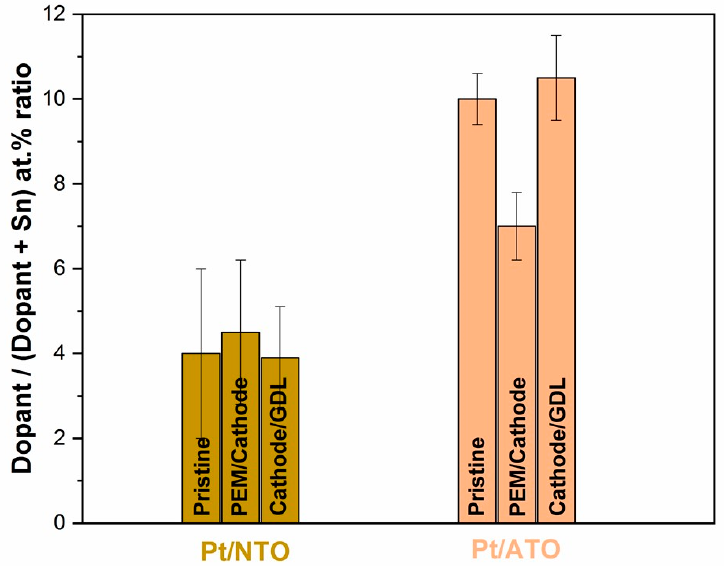
Figure 5. X-EDS analysis carried out on fresh and aged ultramicrotomed pristine / aged MEA to quantify heterogeneities of dopant content at the PEM / cathode and cathode / GDL interfaces.